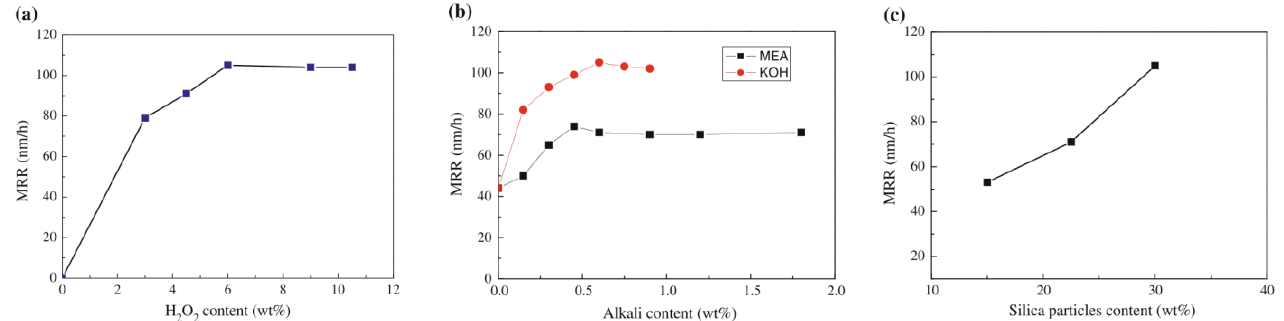
Figure 8. The relationship between the MRR of a SiC wafer and ( a ) H 2 O 2 content, with 0.6 wt% KOH and 30 wt% silica particles; ( b ) different alkali (KOH or MEA) contents, with 6 wt% H 2 O 2 and 30 wt% silica particles; and ( c ) silica particle content, with 0.6 wt% KOH and 6 wt% H 2 O 2 [10].